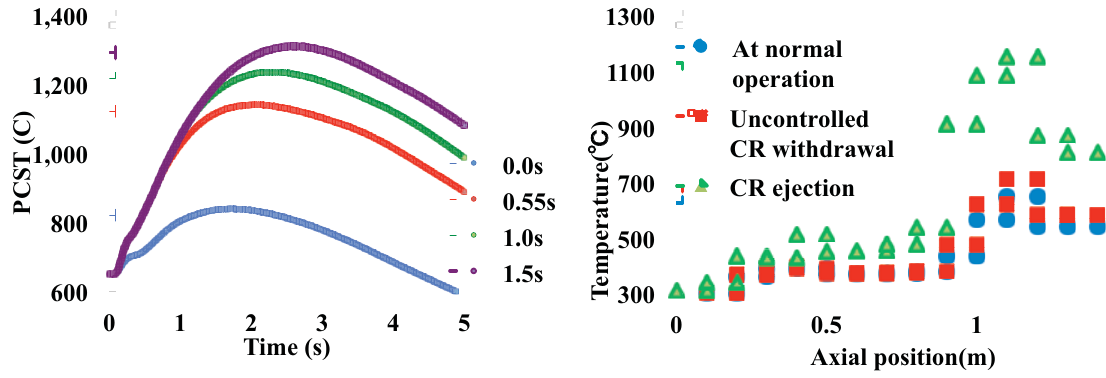
Figure 7: Sensitivity of the delay time Figure 8: Temperatures of each